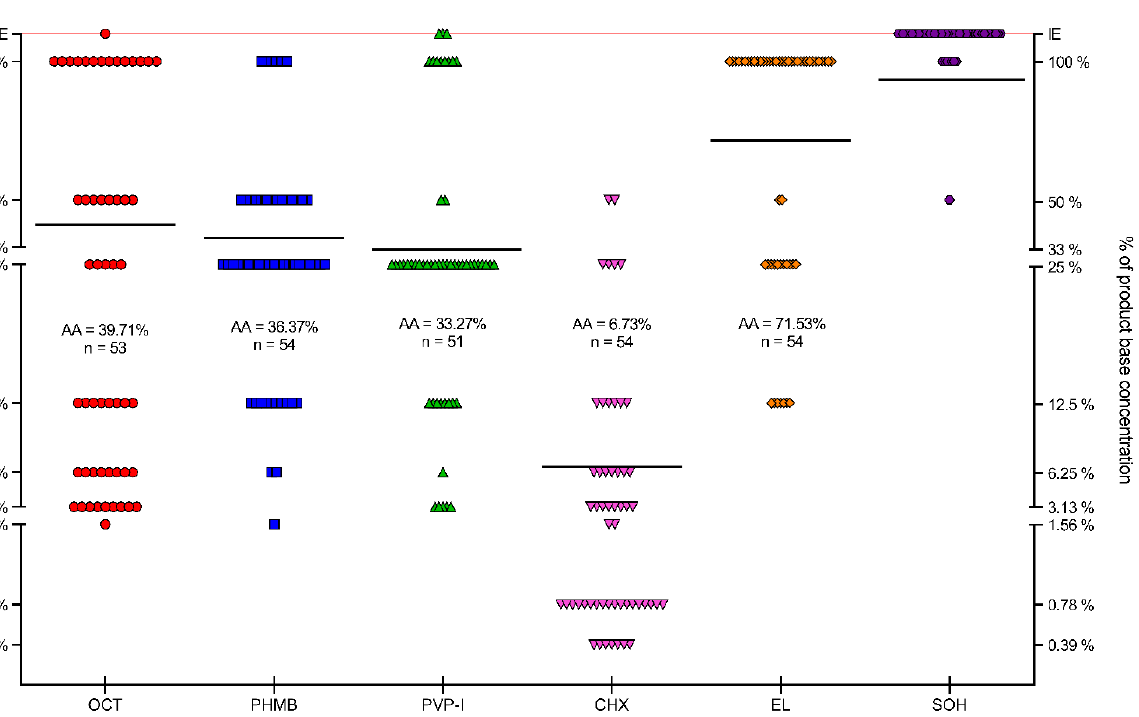
Figure 10. Distribution of MBEC values of the tested substances in the pool of strains. OCT — octenidine dihydrochloride, PHMB — polyhexanide, PVP-I — povidone-iodine, CHX — chlorhexidine, EL — ethacridine lactate, SOH — super-oxidized hypochlorites solution. AA — arithmetic average of MBEC values for all strains (black lines), n — number of strains included in AA, IE — compound ineffective.